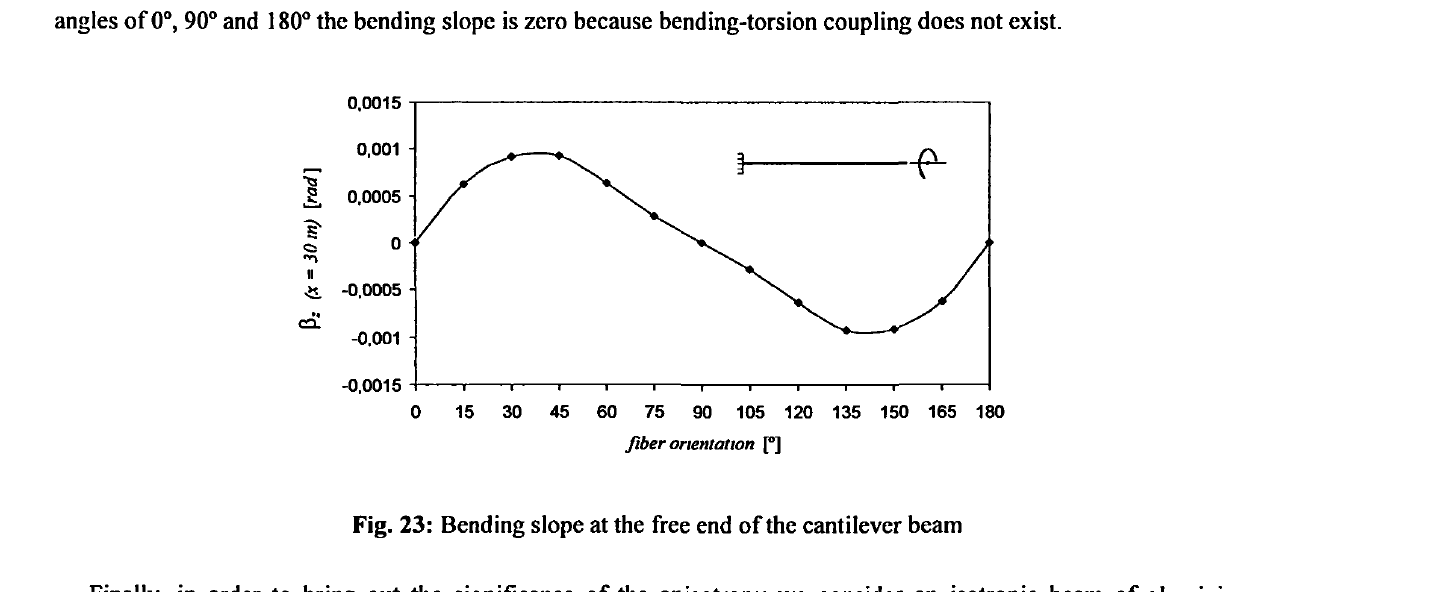
Fig. 23: Bending slope at the free end of the cantilever beam